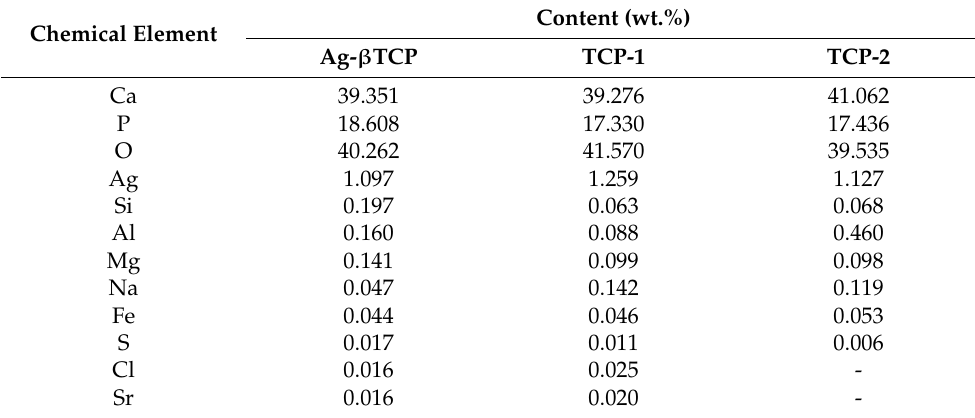
Table 2. The chemical composition of